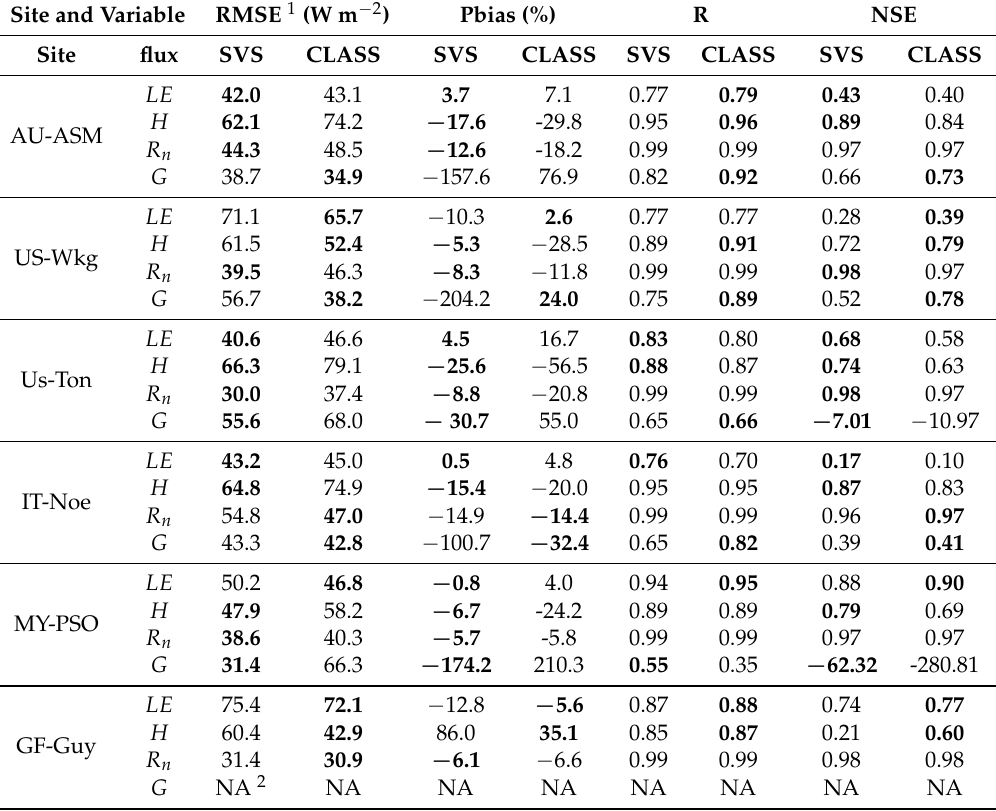
Table 4. Scores for the latent heat flux ( LE ), sensible heat flux ( H ), net radiation ( R n ) and soil heat flux (G) for a 30-min time step 1 . The bold numbers correspond to the best score between both models. Site and